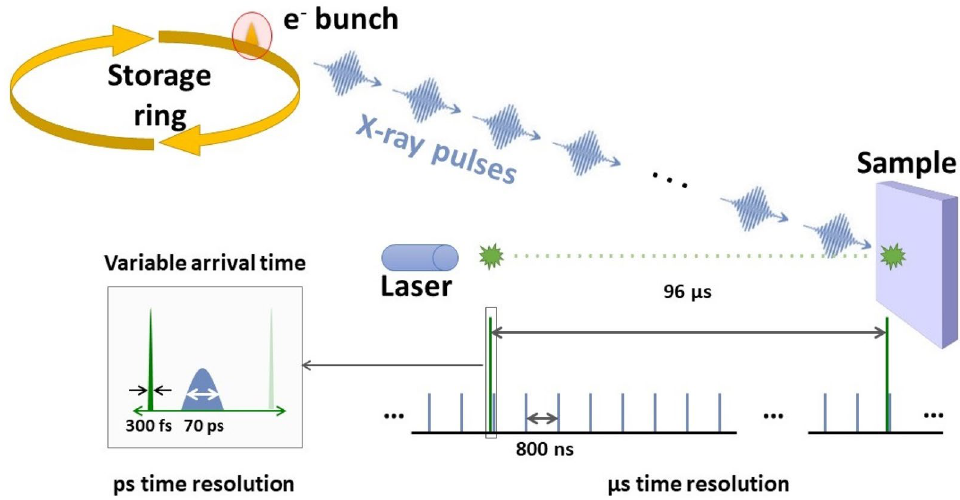
Figure 2. Time structure of pump-probe PES experiments at the LowDosePES end-station at BESSY II. Single bunch mode means that only one electron bunch is circulating in the storage ring, which passes the beamline dipole every 800 ns, generating X-ray photons that hit the sample. The pseudo single-bunch mode can be achieved during standard ring operation using the MHz chopper systemavailable at the end-station 37 . Meanwhile, the laser pulse arrives at the sample every 96 µs at the repetition rate chosen for this experiment. There are therefore 120 X-ray pulses between two laser pulses, giving the possibility of measuring 120 spectra at different pump-probe delay times for a fixed laser arrival time. Shorter pump-probe delay times can be measured by varying the arrival time of the pump laser in relation to the X-ray pulse train (bottom left